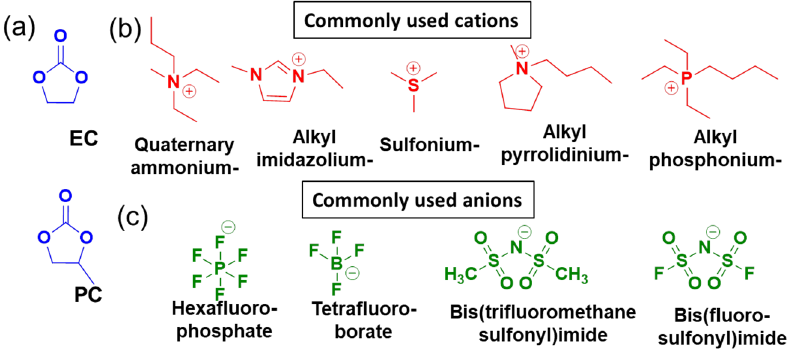
Figure 4. Chemical structures of ( a ) commonly used organic solvents (EC and PC), and ( b ) cationic and ( c ) anionic species of